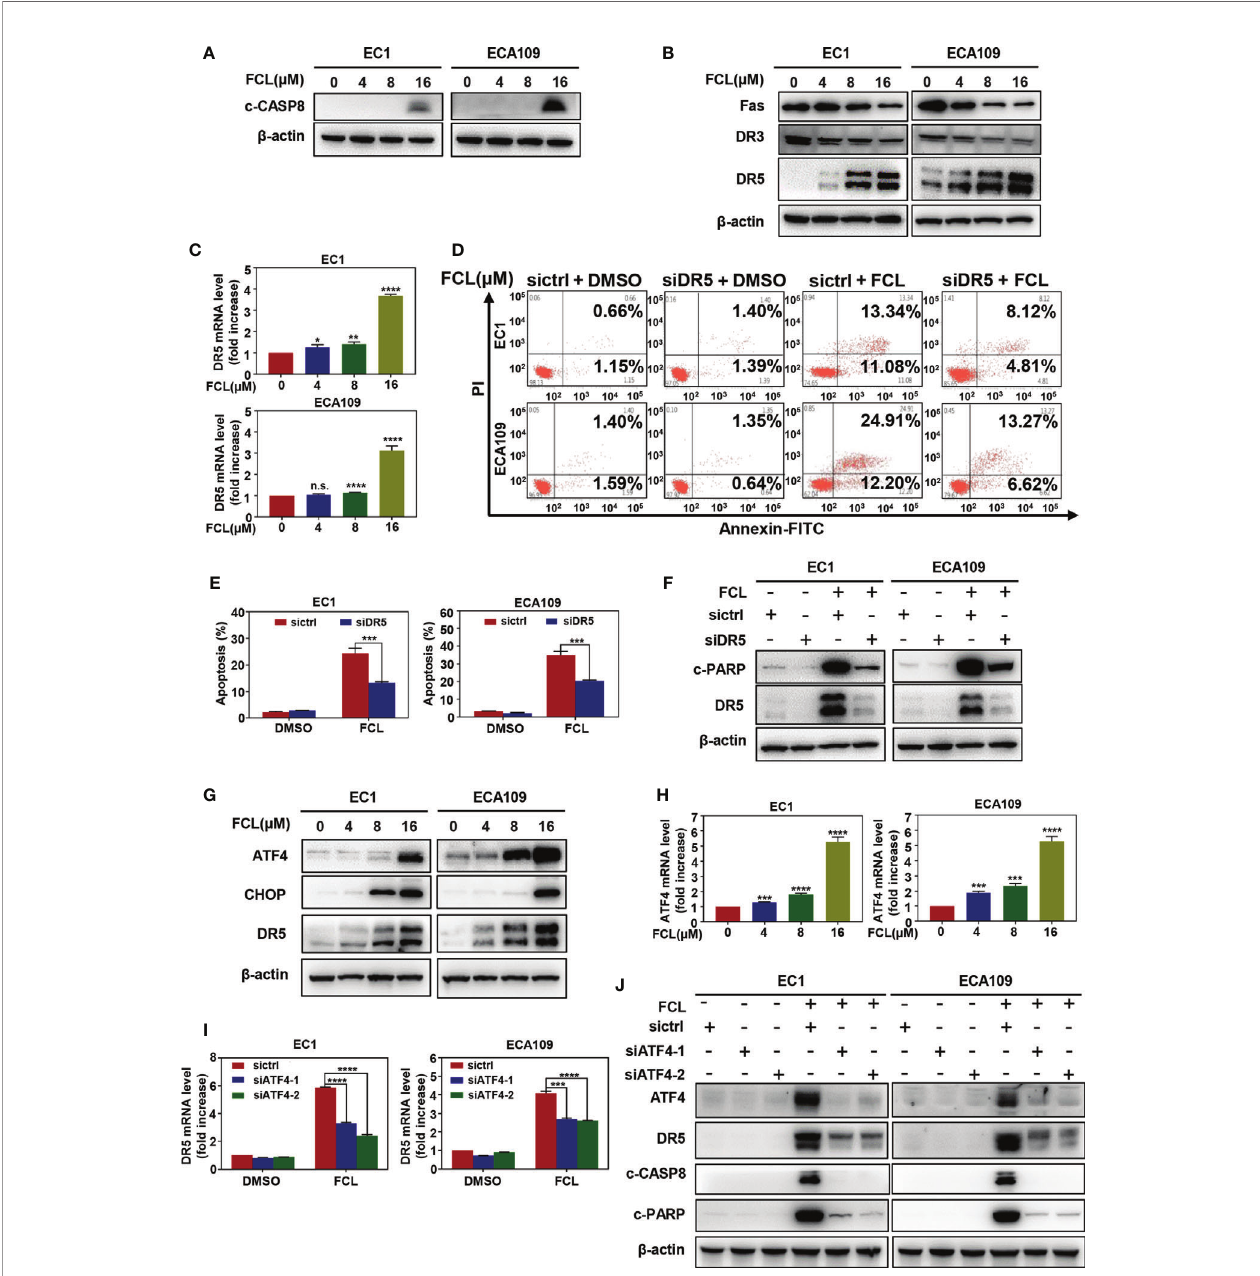
FIGURE 5 | Fangchinoline activated extrinsic apoptosis via the ATF4-DR5 axis. (A) FCL induced the activation of CASP8. EC1 and ECA109 cells were treated with FCL as described above and were subjected to Western blotting using the antibodies against c ‐ CASP8 and c ‐ CASP3 with b -actin as a loading control. (B) The expression of death receptors Fas, DR3 and DR5 was determined. EC1 and ECA109 cells treated with FCL at the indicated concentrations for 24 hours, followed by Western blotting using the indicated antibodies with b -actin as a loading control. (C) FCL increased the mRNA level of DR5. The mRNA level of DR5 was determined by the real-time PCR in EC1 and ECA109 cells. (D, E) Knockdown of DR5 inhibited apoptosis induced by FCL. EC1 and ECA109 cells were transfected with control or DR5 siRNA (72 hours), and then treated with FCL (16 m mol/L) for 24 hours. Apoptosis induction was quanti fi ed by Annexin V – FITC/PI double-staining analysis. (F) Apoptosis induction was quanti fi ed by Western blotting using an antibody against c ‐ PARP with b -actin as a loading control. (G) FCL induced the accumulation of ATF4, CHOP and DR5. EC1 and ECA109 cells were treated with FCL at the indicated concentrations for 24 hours, followed by Western blotting using antibodies against ATF4, CHOP and DR5 with b -actin as a loading control. (H) The mRNA level of ATF4 was determined by real-time PCR in EC1 and ECA109 cells. (I, J) The expression of ATF4 mediated FCL-induced apoptosis in ESCC cells via ATF4-DR5 axis. ATF4 mediated FCL-induced DR5 upregulation. EC1 and ECA109 cells were transfected (72 hours) with control or ATF4 siRNA, treated with FCL (16 m mol/L) for 24 hours. Expression of ATF4, DR5, c-CASP8 and c-PARP was assessed by Western blotting. Transcriptional regulation of ATF4 on DR5 was analyzed by real-time PCR. *denotes P < 0.05, **denotes P < 0.01, ***denotes P < 0.001, **** denotes P < 0.0001, n.s. denotes not signi fi